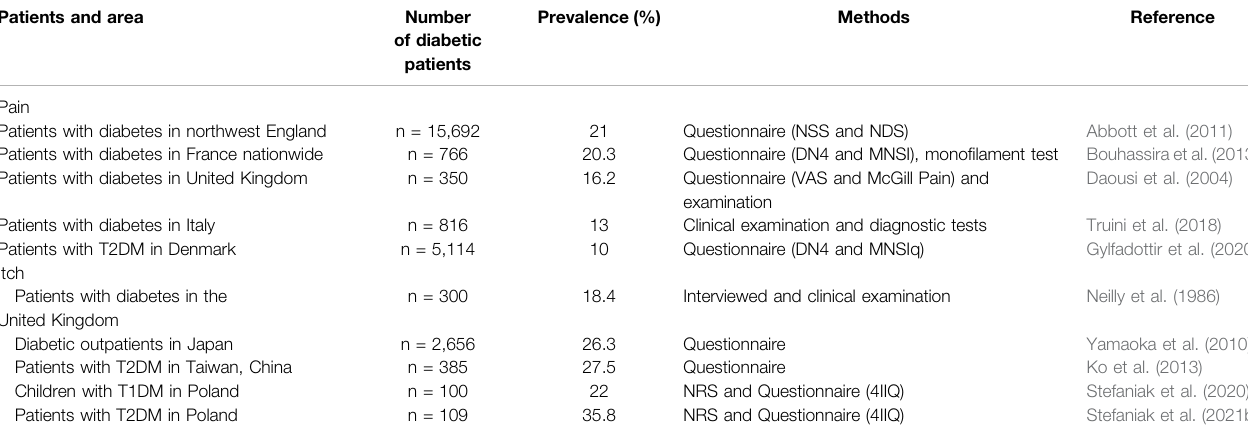
TABLE 2 | Prevalence of pain and itch in diabetes in different areas, assessment methods in different studies. Patients and